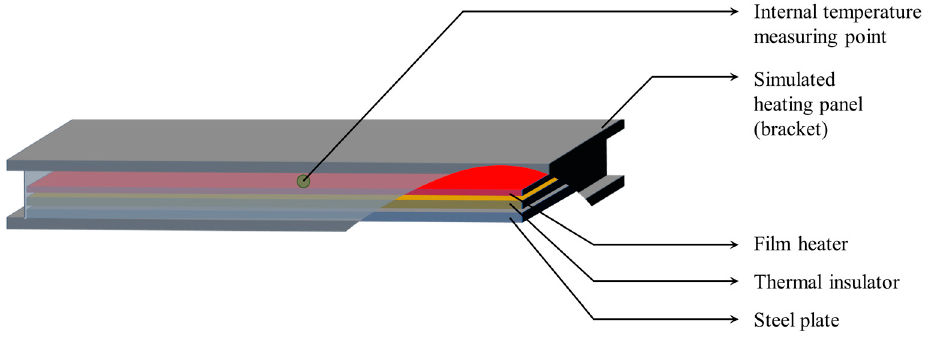
Figure 4. Conceptual design of the testing device.